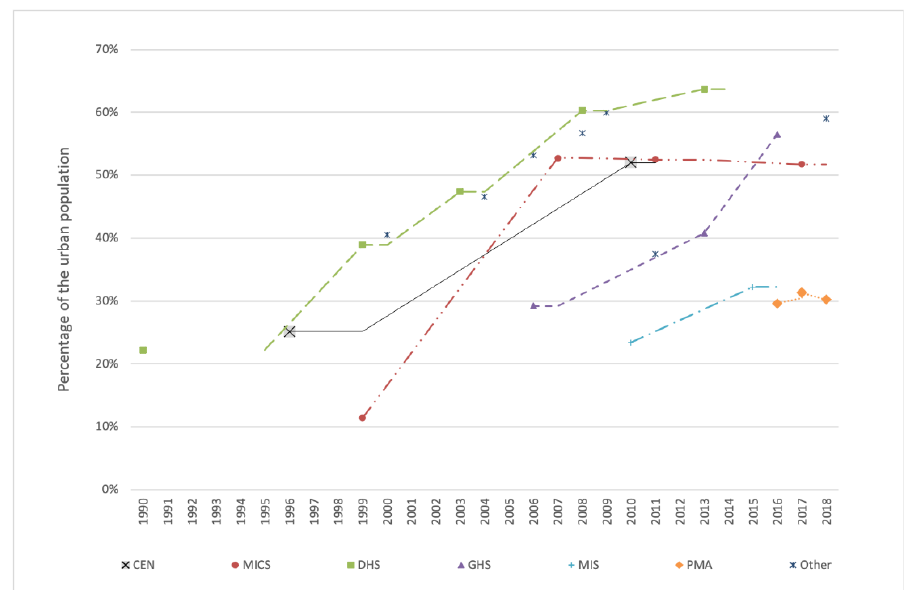
Figure 1. Proportion of urban population using wells as their main source of drinking water as reported by national surveys and census (%, Nigeria).